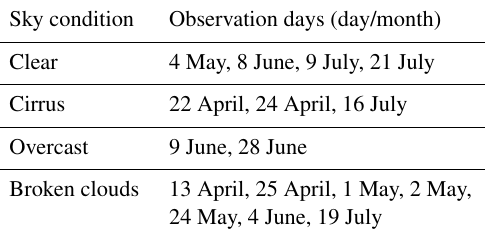
Table 1. Classification of days into clear, cirrus, overcast, and bro- ken cloudy-sky condition during the HOPE Jülich